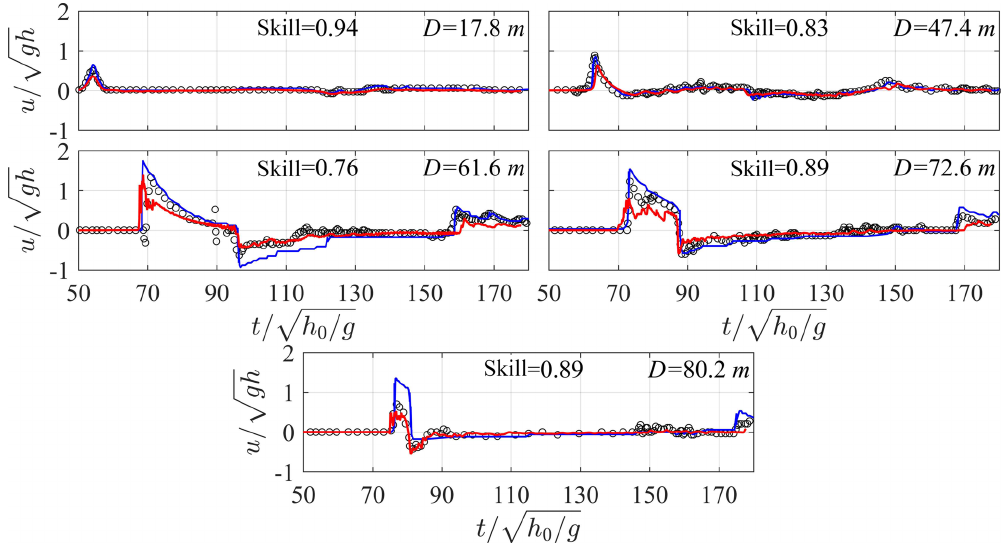
√ gh ) at different cross-shore distances from the wavemaker ( D ) for Sce-